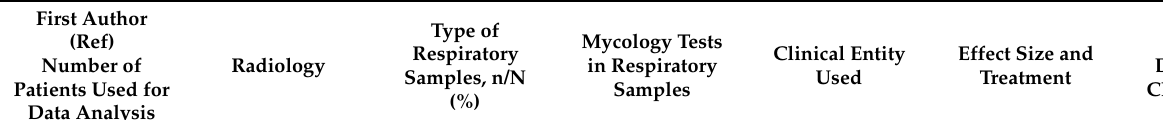
Table 2. Diagnostic methods applied to the patients and the definition of clinical entity used in the study, ordered by alphabetical order of first author’s